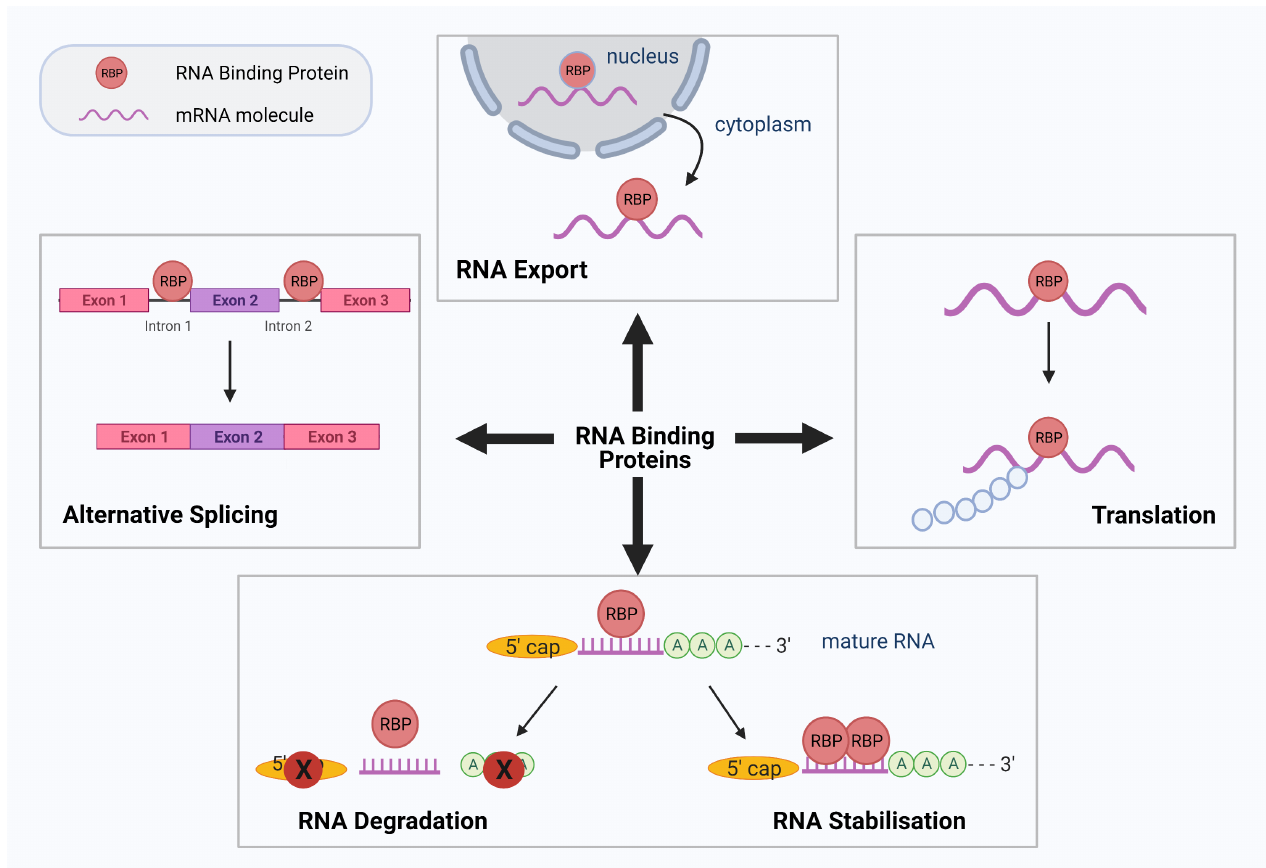
Figure 1. Schematic diagram summarizing the various roles of RNA binding proteins (RBPs). RBPs have numerous roles in RNA processing and translation. Four such functions of RBPs are demonstrated diagrammatically above: alternative splicing, RNA export, protein translation, RNA degradation, and stabilization. Figure created using